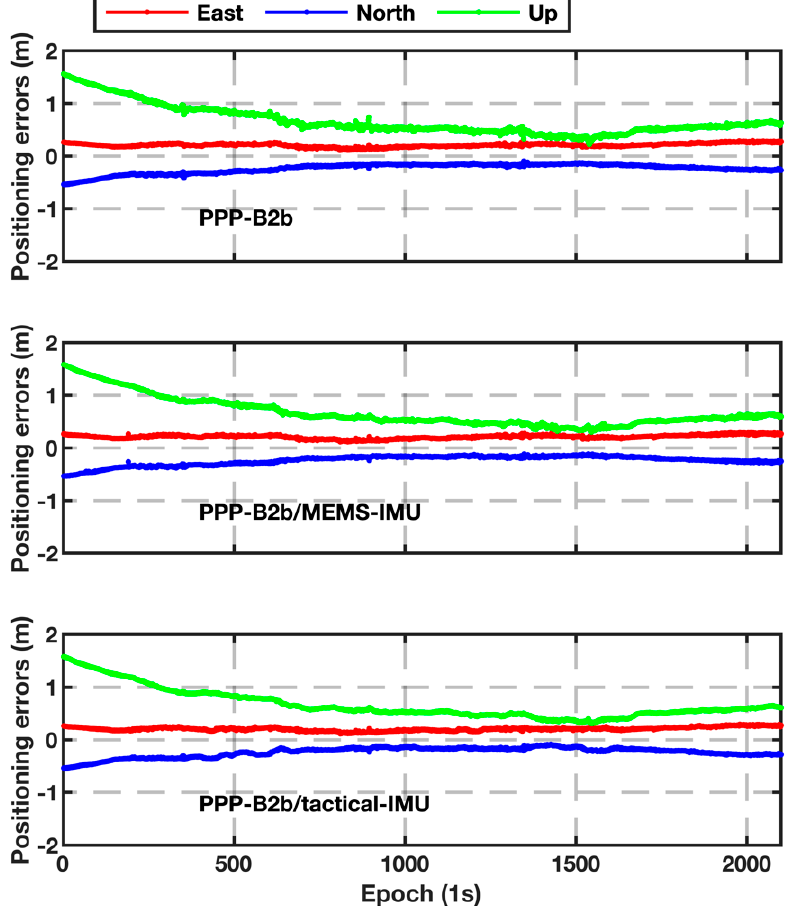
Figure 9. Positioning errors of PPP-B2b only ( top panel), PPP-B2b/MEMS-IMU loosely coupled integration ( middle panel), and PPP-B2b/tactical − IMU loosely coupled integration ( bottom panel) during the period from 09:00:00 to 09:34:59.